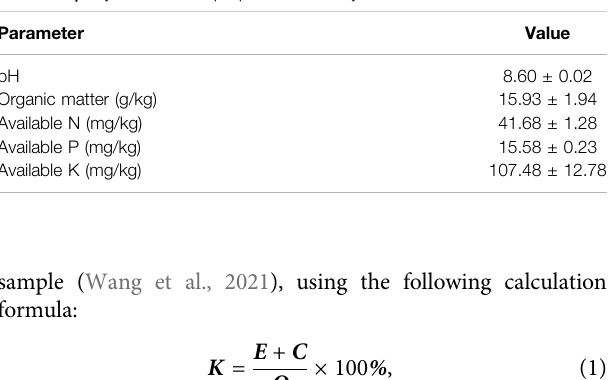
TABLE 2 | Physicochemical properties of the fl y ash.